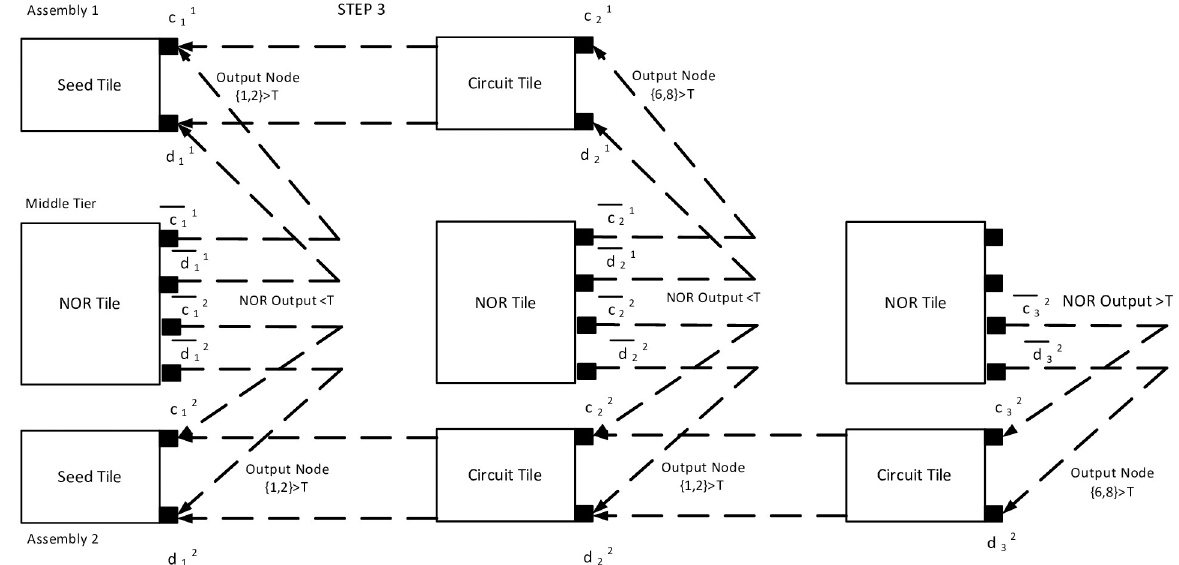
Fig 11. Step 3 of the example assembly. Fig. shows the third step for the example case. Both of the assemlies have V B output is also < τ